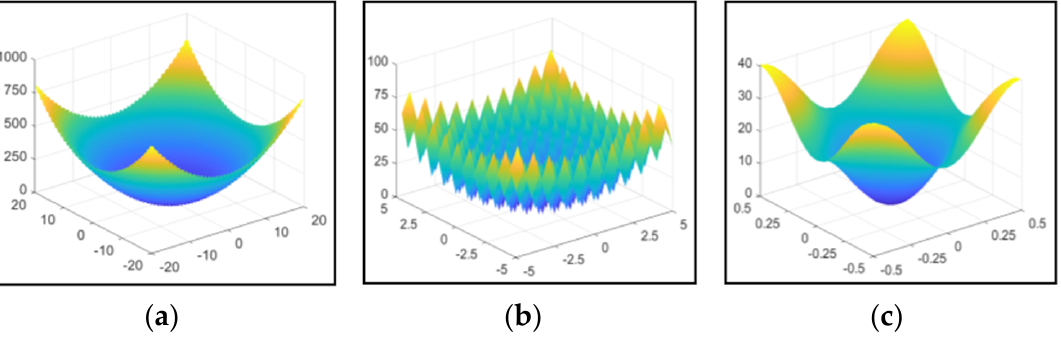
Figure 5. Rastrigin function: ( a ) x i ∈ [ − 20,20 ] ; ( b ) x i ∈ [ − 5,5 ] ; and ( c ) x i ∈ [ − 0.5,0.5 ] .